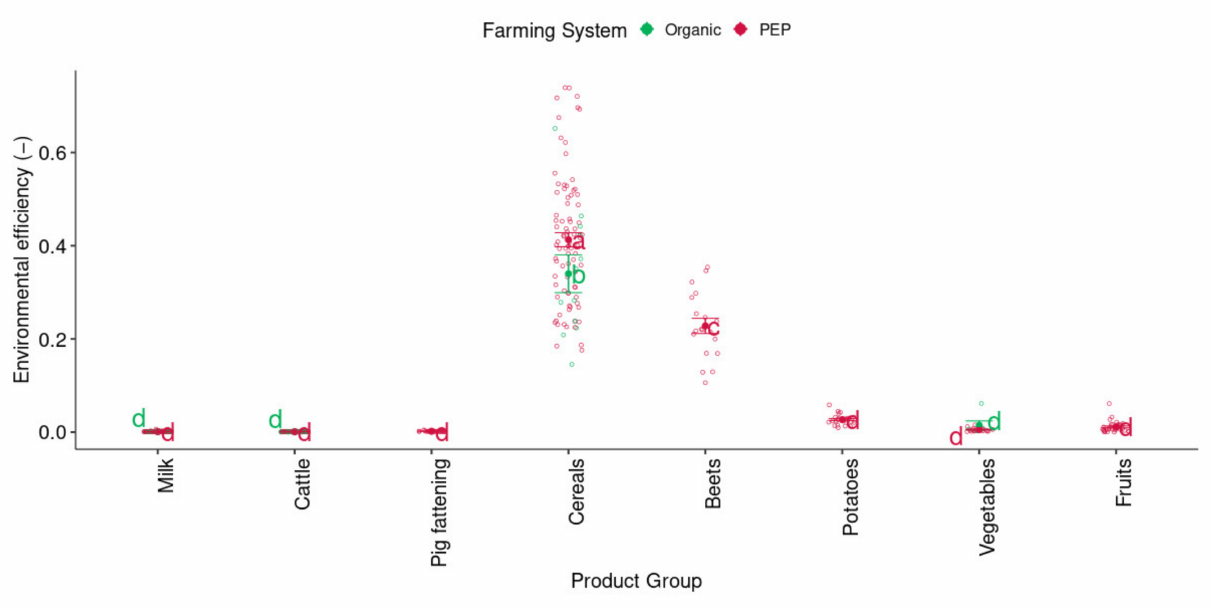
Figure A5. Environmental impacts per produced amount (kg) for the different product groups and farming systems. Shown are mean values and 95% confidence interval.